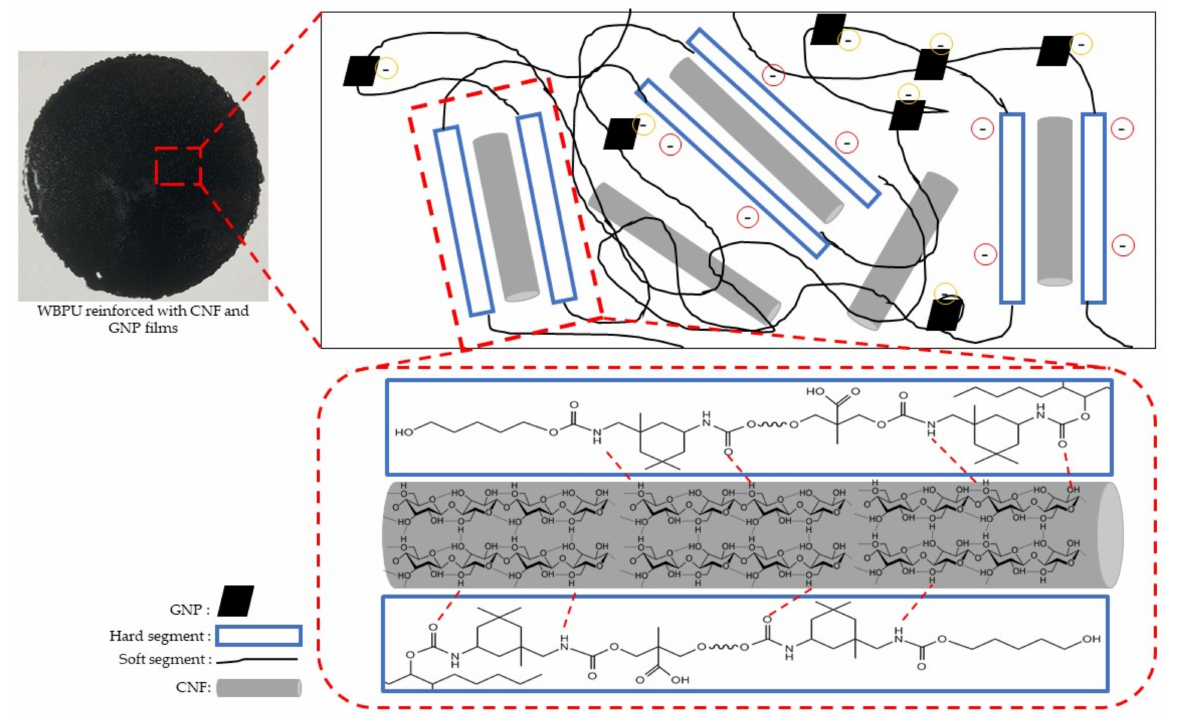
Figure 5. The schematic diagram of electrostatic force and distribution of CNF and